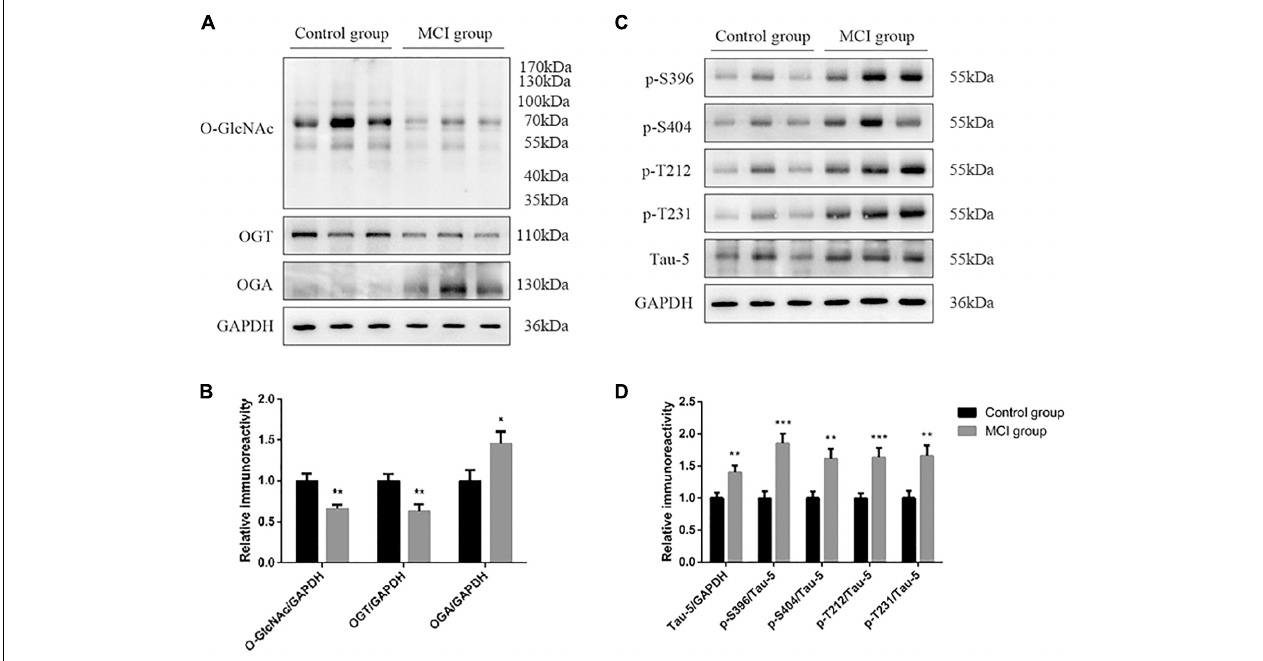
FIGURE 1 | Global O -GlcNAcylation and tau phosphorylation levels in the whole blood of T2DM subjects. (A) Representative Western blot analysis showing that global O -GlcNAcylation and OGT expression are decreased, while OGA expression are increased in T2DM with MCI compared to those with normal cognition. (B) Quantitation of Western blot analysis (A) . (C) Representative Western blot analysis showing that total tau level, as well as phosphorylation of tau protein at specific sites including Ser396, Ser404, Thr212, and Thr231 are increased in T2DM with MCI compared to those with normal cognition. (D) Quantitation of Western blot analysis (C) . All data represents n = 48, and are means ± standard error of mean. ∗ p < 0.05, ∗∗ p < 0.01, ∗∗∗ p < 0.001.